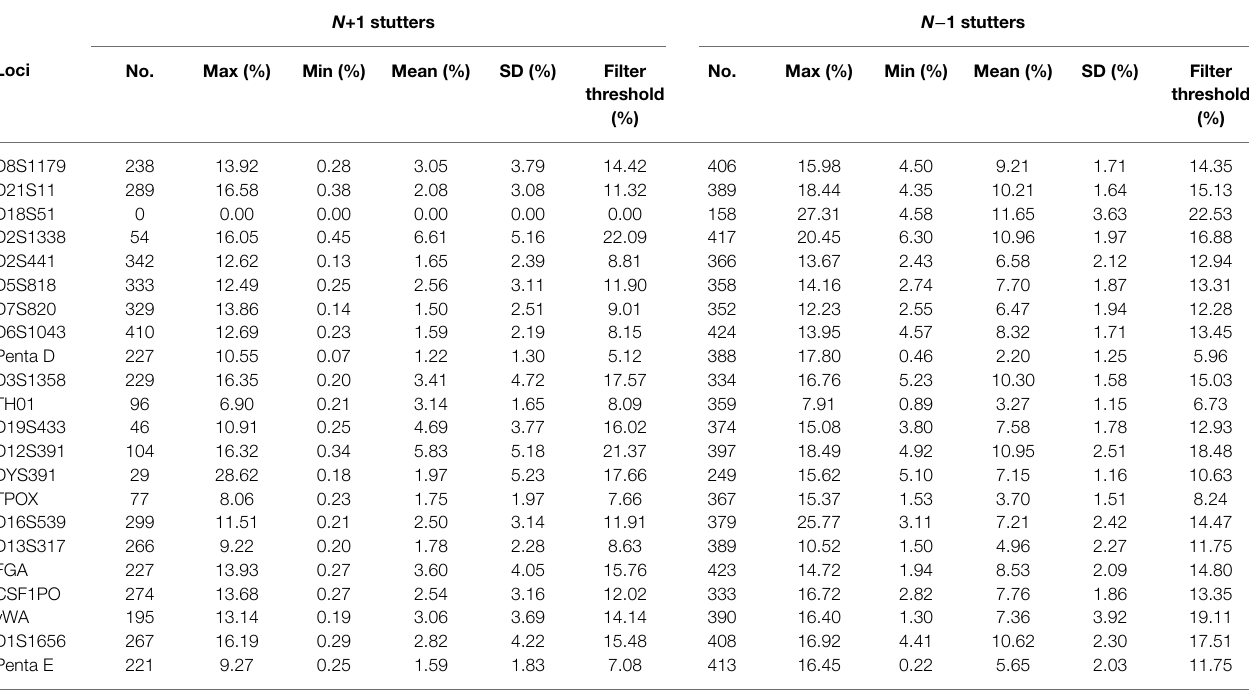
TABLE 3 | Observed stutter ratios, SDs, and stutter filter thresholds in RFUs determined for 254 samples. N +1 stutters N − 1 stutters Loci No.